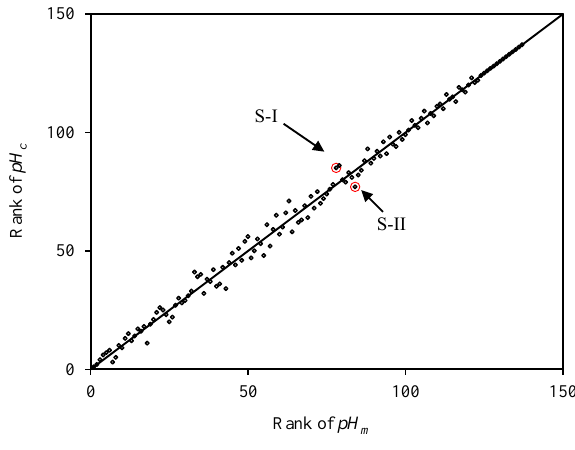
Figure 1. Comparison of the rank of pH m and pH c .